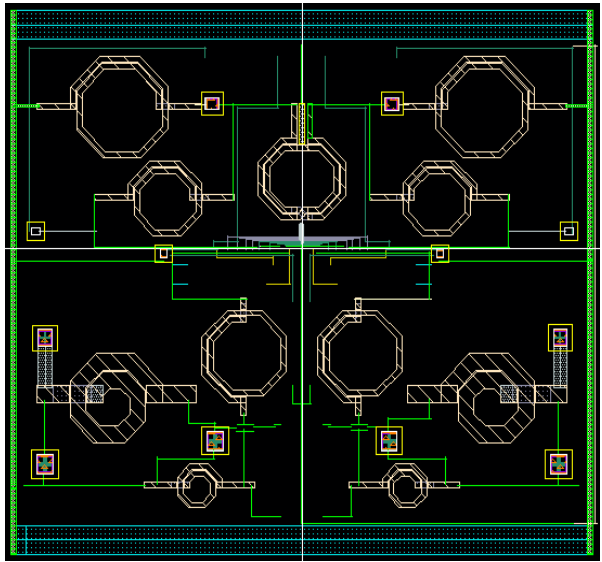
Figure 15. Full layout for the presented VGA at 10 GHz. Table 4. Comparison between the achieved specifications from the proposed tool at the three test frequencies and the required ones.